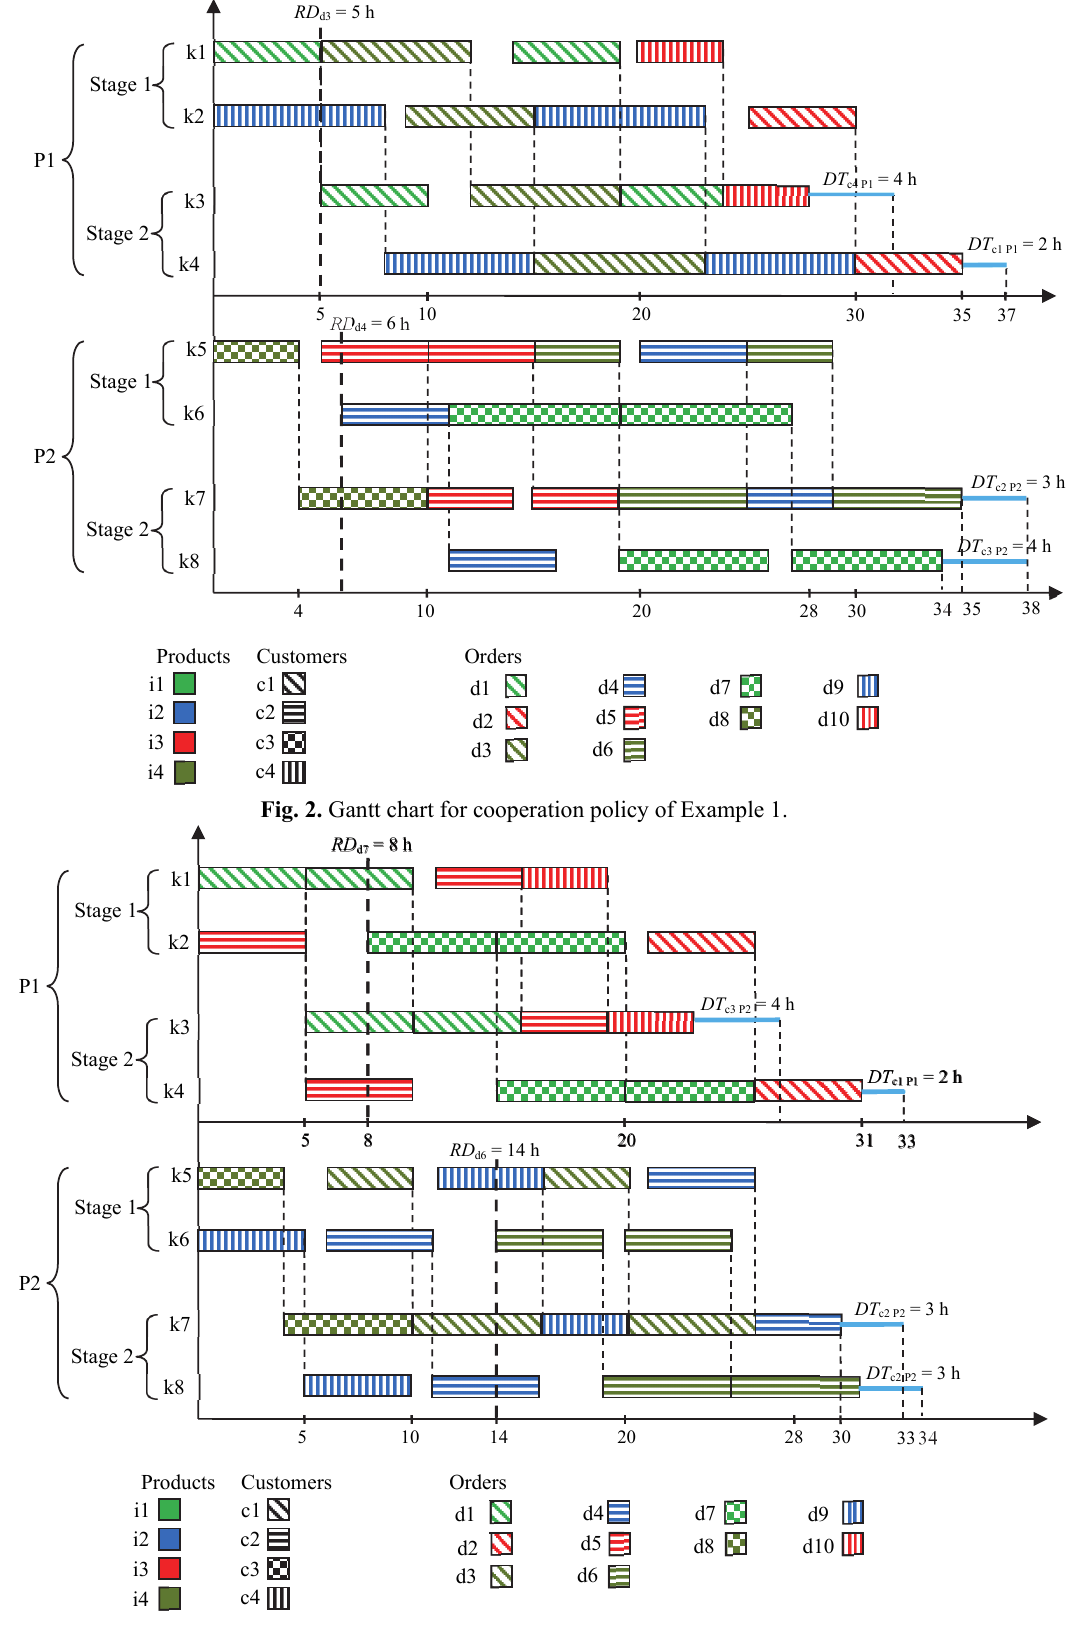
Fig. 3. Gantt chart for coordination policy of Example